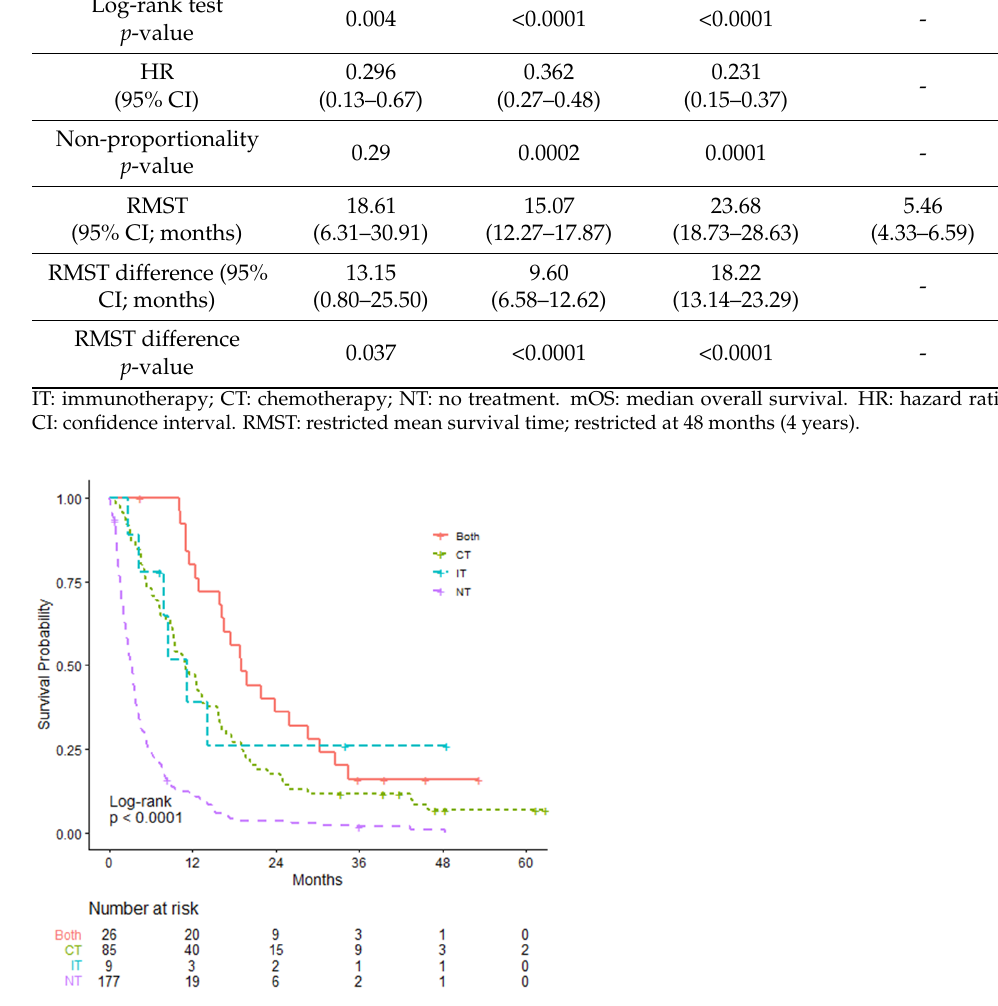
Figure 2. Overall survival in patients receiving palliative therapies, calculated from date of metas- tasis. Chemotherapy (CT), immunotherapy (IT), chemotherapy and immunotherapy (both) or no treatment (NT).